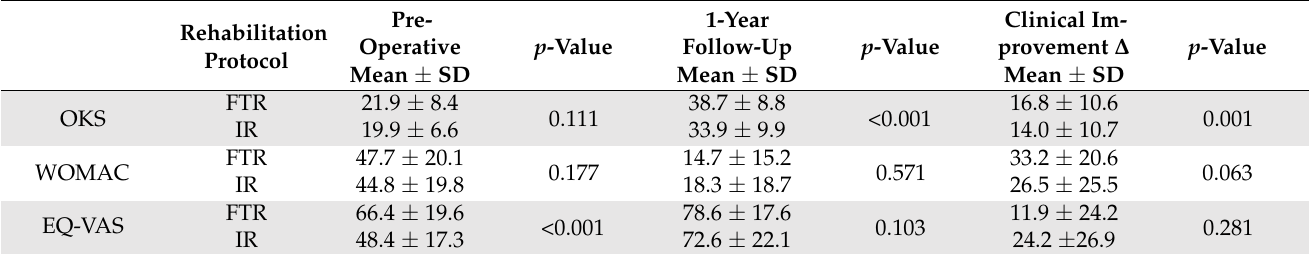
Table 2. Clinical scores in both groups.